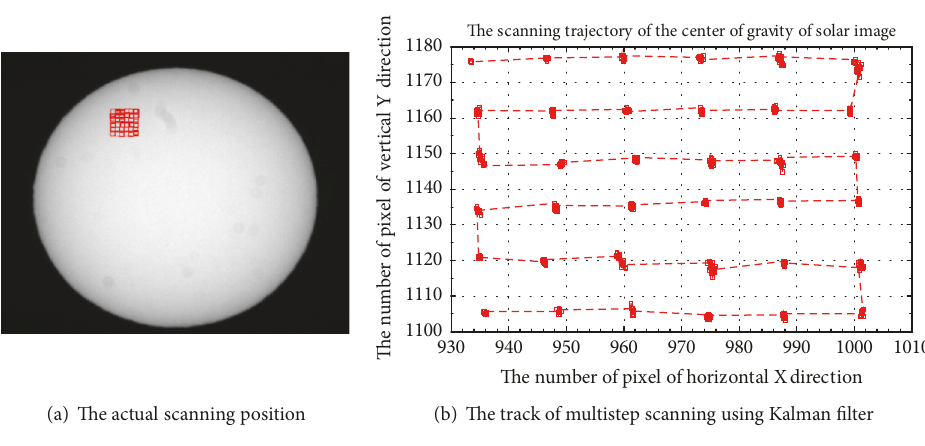
Figure 10: The track of the center of gravity of full-disk solar image using Kalman